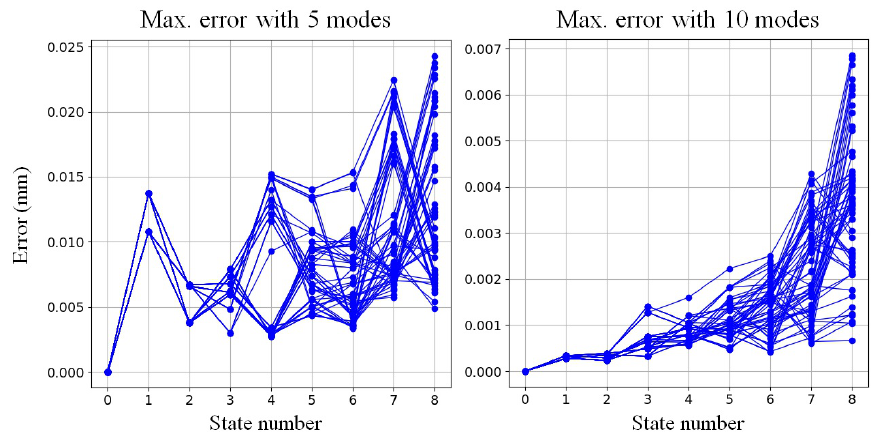
Figure 8. Approximation error when using 5 and 10 modes in the reduced